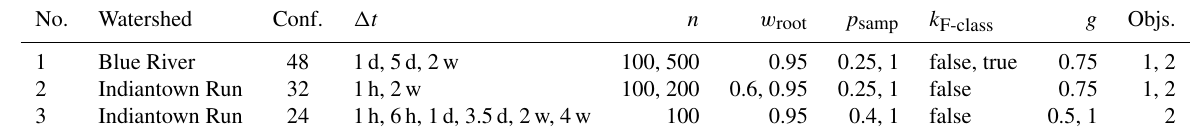
Table 4. Set-up of the three factorial experiments, including the watershed, the total number of configurations (conf.), the values assigned to OPTIMISTS’ parameters, and which objectives (objs.) were used (one objective: minimize MAE given the streamflow observations; two objectives: minimize MAE and maximize likelihood given the source or background state distribution S t ). n evo was set to 25 in all cases. The total number of configurations results from combining all the possible parameter assignments listed for each experiment. Note that for Experiment 3 there are configurations that require a 4-week assimilation period (all others have a length of 2 weeks).